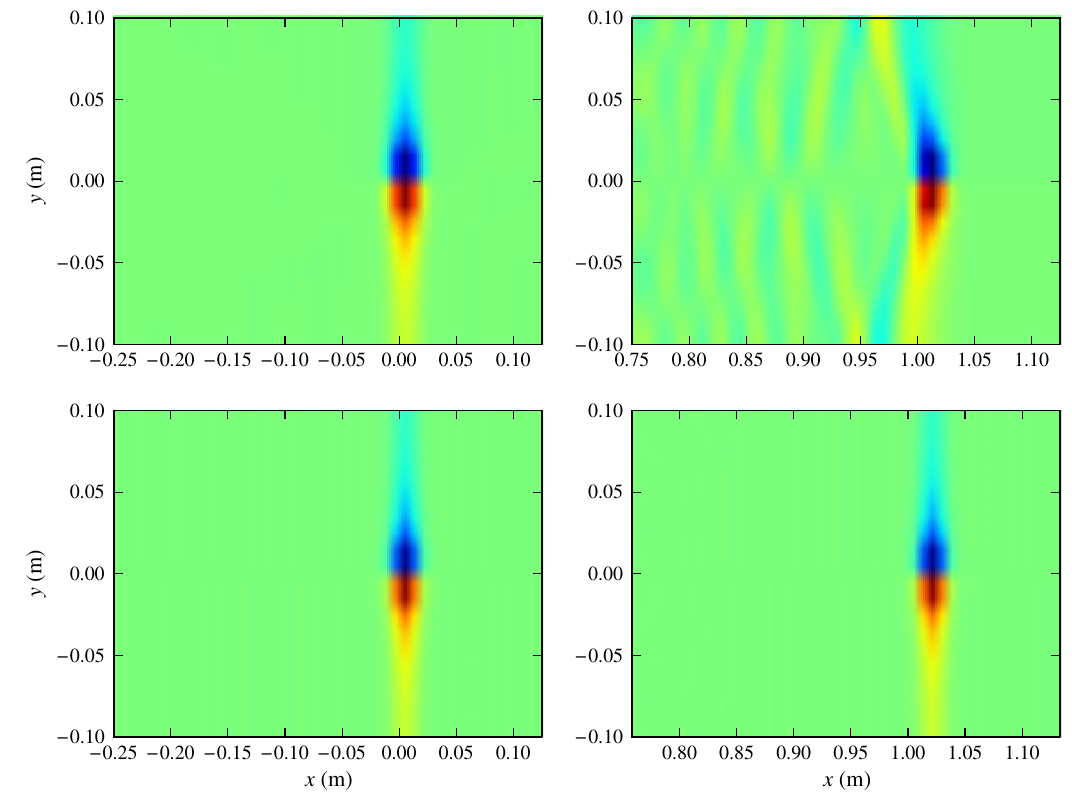
FIG. 4. Transverse field E at the pipe midplane in z . Top left: Initial field with the normal dispersion algorithm; bottom left: initial y field with the controlled dispersion algorithm; top right: field after 1 m propagation with normal dispersion; bottom right: field after propagation with controlled